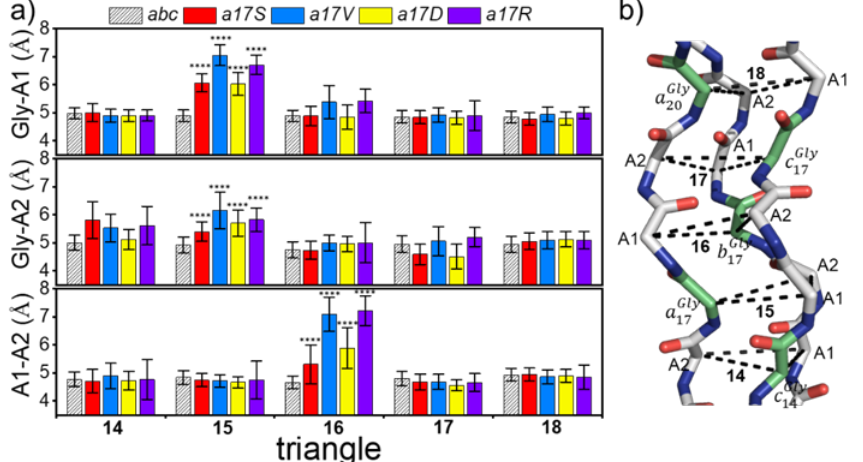
Figure 4. The side length of the C α triangle after substitution. ( a ) The side lengths of the 14th–18th triangle of abc and chain a mutants. abc is represented by a bar graph with right-slanted lines, and other mutants are shown in various colors, as indicated in the above. ( b ) 14th–18th triangle structure of abc ; Gly is shown in lime green; A1 and A2 sites are marked in the graph. Statistical significance was calculated using one-wany ANOVA. Values are mean ± SD. **** p < 0.0001, versus abc alone.